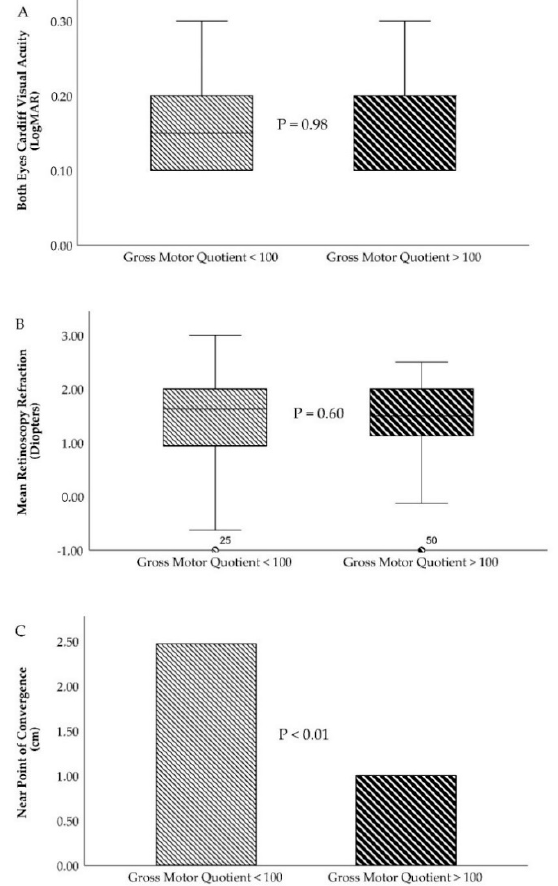
Figure 3. Slow and fast motor development characteristics for main optometry variables. ( A )—Box and plot graph for both eyes’ visual acuity (Cardiff test, expressed in LogMAR). ( B )—Box and plot graph for mean retinoscopy refraction (expressed in diopters). ( C )—Near point of convergence (expressed in cm).